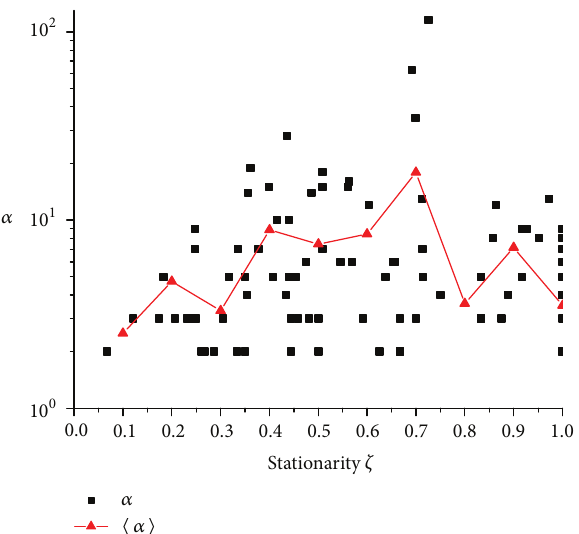
Figure 9: Scatter plot of correlations between the dynamic commu- nity age 𝛼 and the dynamic community stationarity 𝜁 . ⟨𝛼⟩ represent the arithmetic average value of 𝛼 .